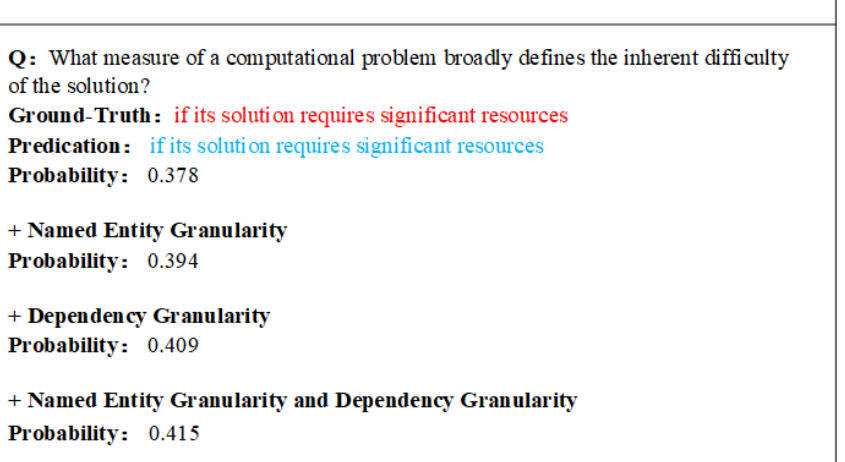
Figure 10. Effectiveness analysis. Example of the answer is the possibility of long sentence.